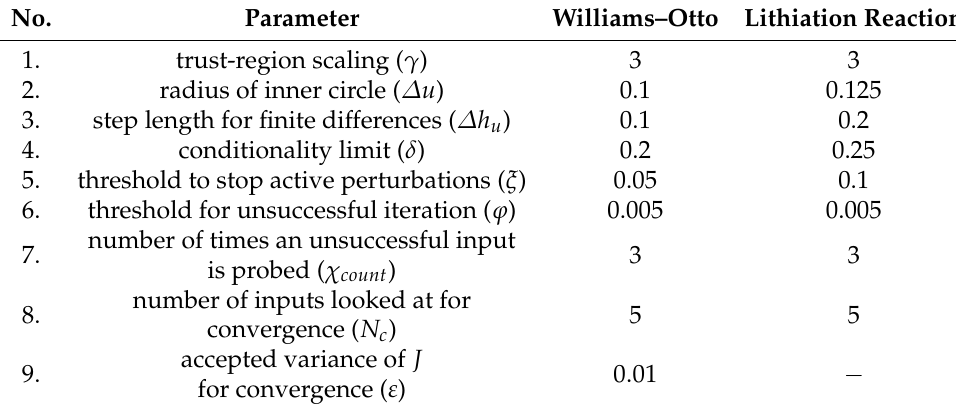
Table 1. Tuning parameters for simulation study.